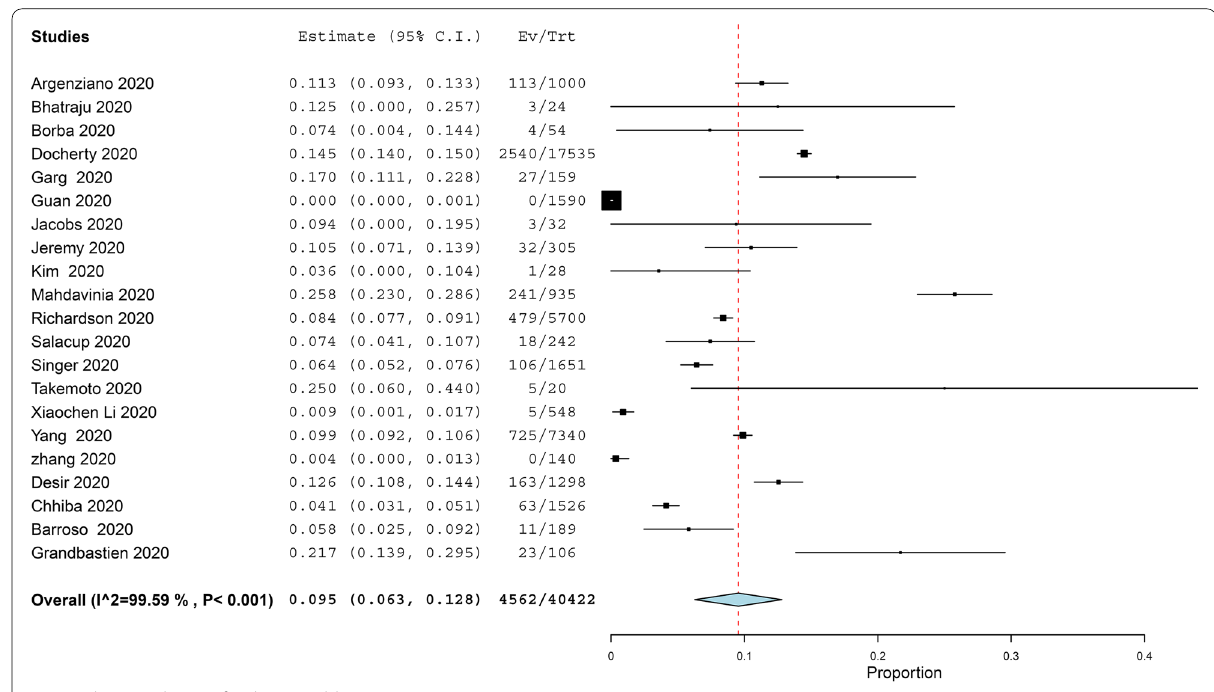
Fig. 2 The prevalence of asthma in old COVID‑19 patients